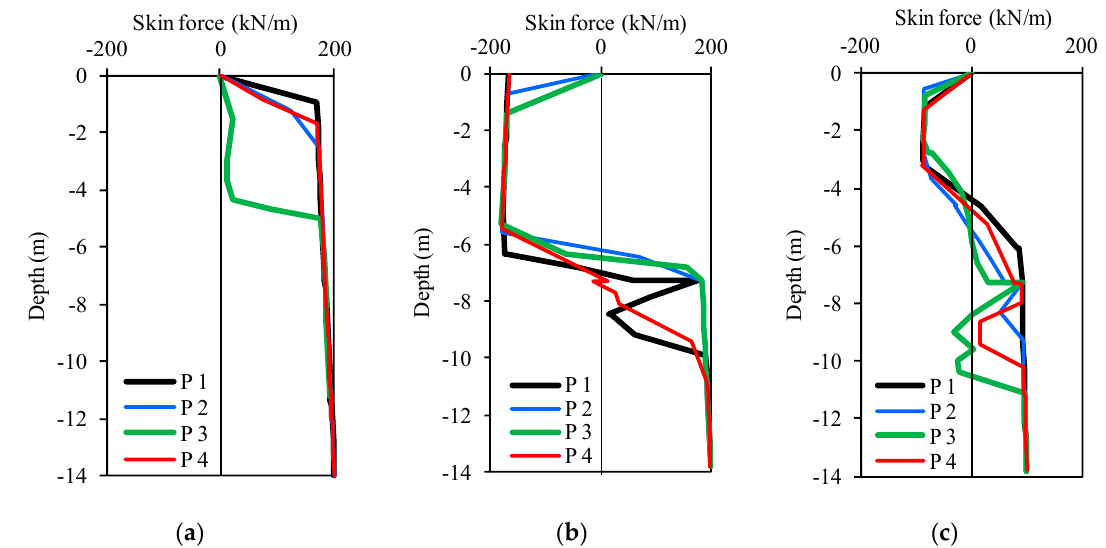
Figure 14. Lateral frictional distribution of the pile: ( a ) raft + bored pile; ( b ) raft + cushion + bored pile; ( c ) raft + cushion + CFG pile.